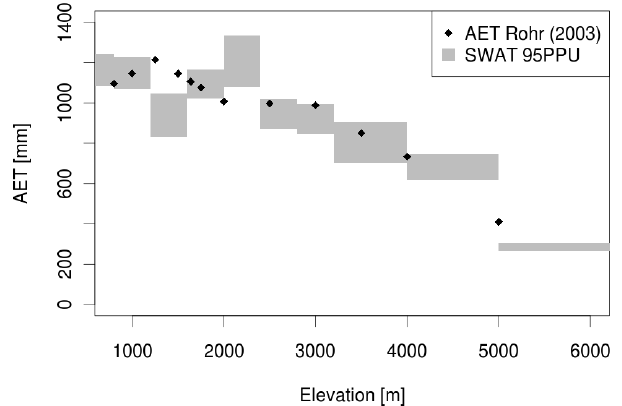
Fig. 6. Comparison of actual evapotranspiration by elevation on the Southern Kilimanjaro slopes calculated with the CRAE method by Røhr (2003) and modelled with SWAT in this study.